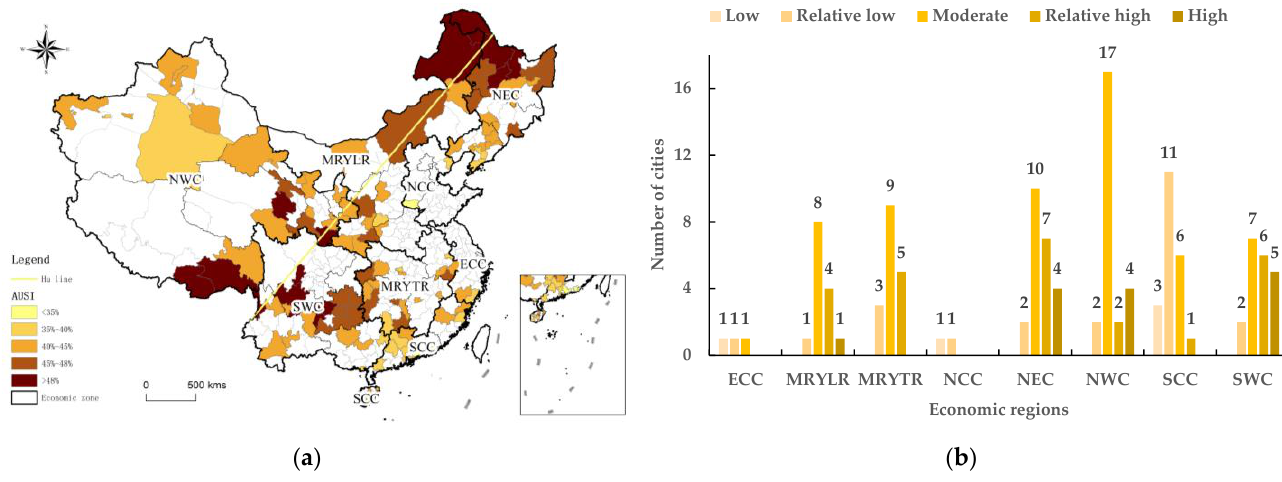
Figure 4. ( a ) Spatial pattern of shrinking cities based on AUSI; ( b ) AUSI level statistics by economic regions .